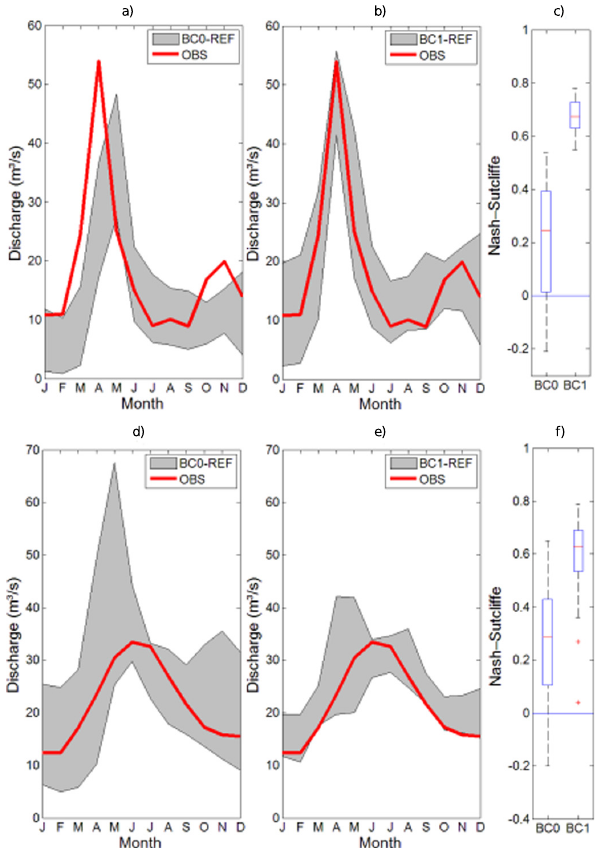
Fig. 5. Mean monthly observed discharge (red line) and the enve- lope of the ensemble simulations (1971–2000) with (a) BC0 for Saumon , (b) BC1 for Saumon , (d) BC0 for Schlehdorf , (e) BC1 for Schlehdorf . The box plots to the right ( c and f ) present Nash– Sutcliffe model efficiency based on daily